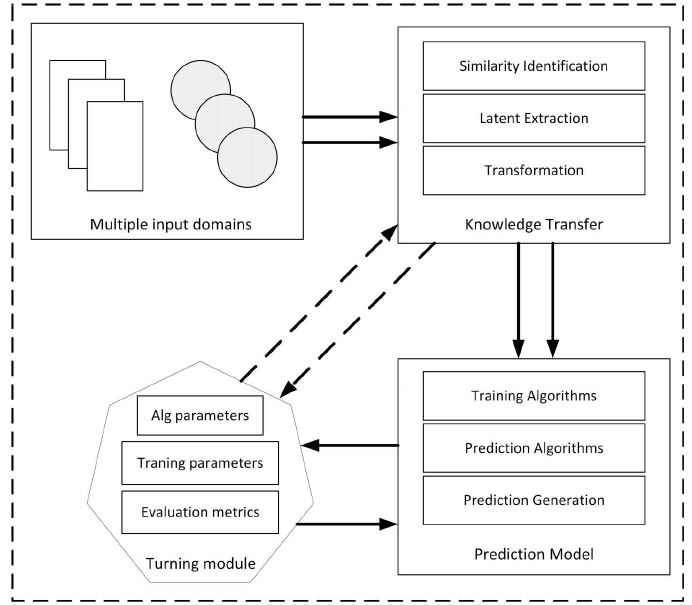
Figure 2. Conceptual framework for cross-domain recommendation system.